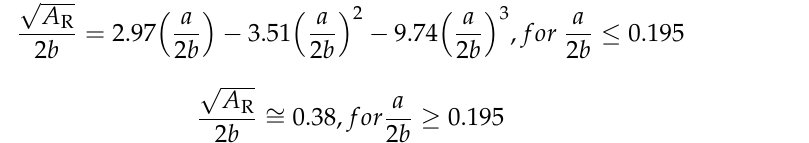
Table 4. Fatigue strength of Murakami model and related